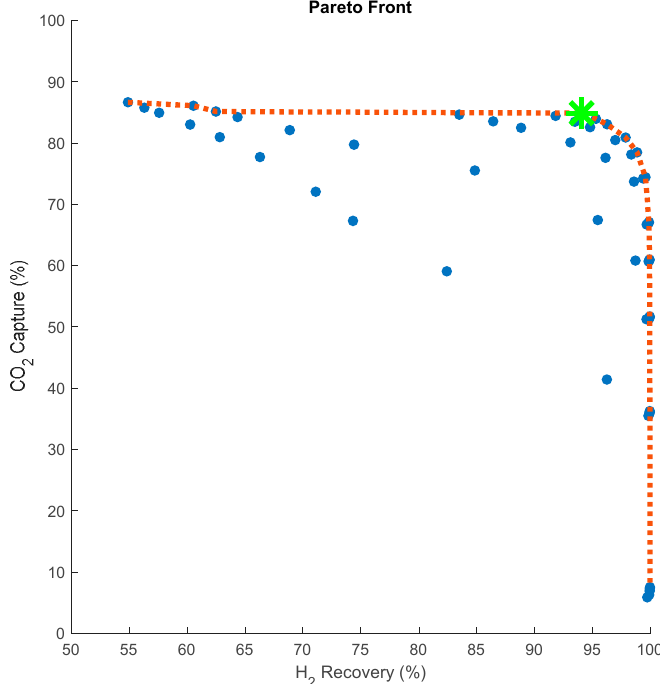
Figure 9. AOS points with the Pareto frontier included and the “best compromise” marked by a star.